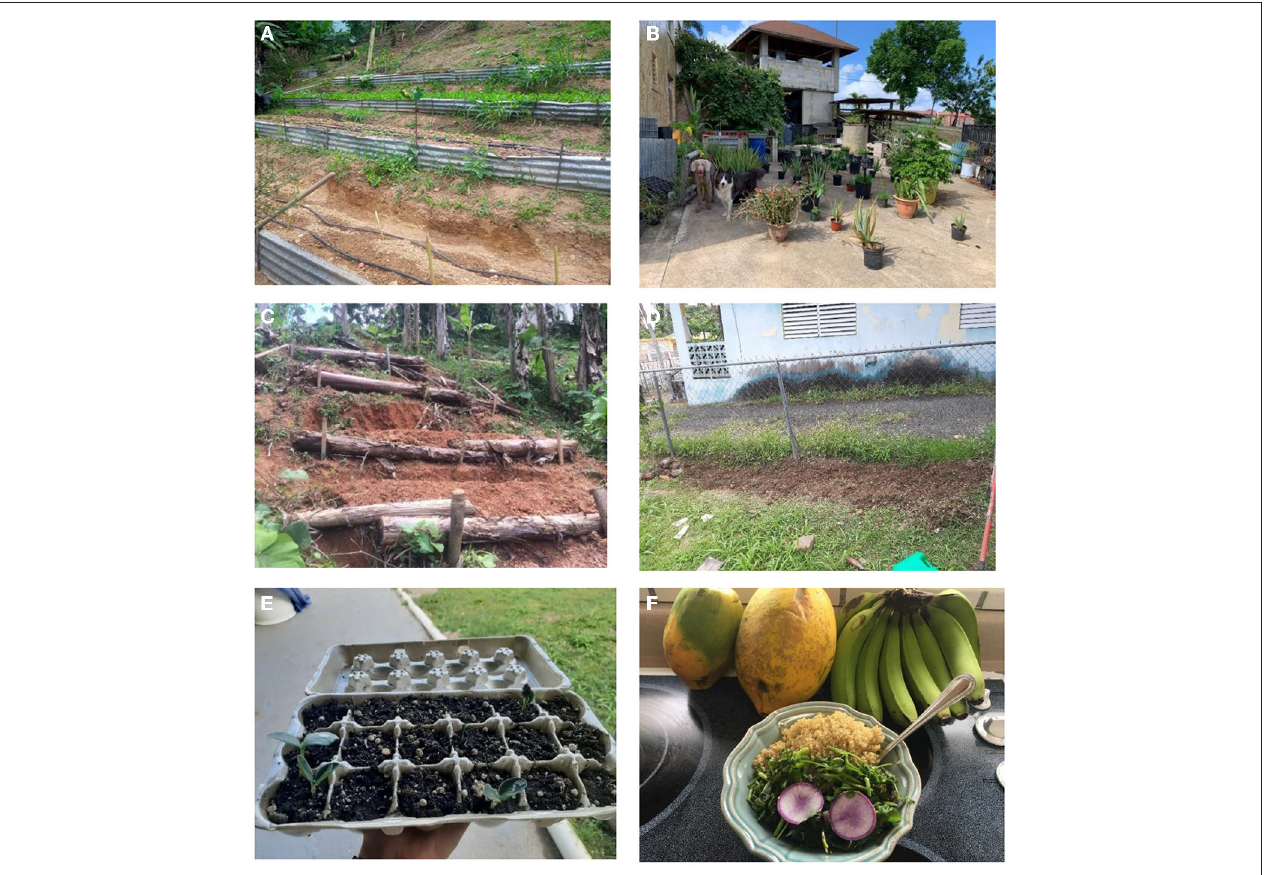
FIGURE 1 | Creation of new food production areas at home during COVID-19: photo examples from student assignments in the “agroecology in practice” module at the University of Puerto Rico at Utuado, May 2020. (A) Rural planting beds in terraces (Corozal, Puerto Rico). (B) Urban home-garden in planting pots (Toa Baja, Puerto Rico). (C) Implementation of soil erosion-mitigation practices on steep terrain (Utuado, Puerto Rico). (D) Re-designing urban areas and implementing agroecological urbanism (Caguas, Puerto Rico). (E) Recycling egg boxes as germination plates (Cidra, Puerto Rico). (F) Exploring the ethnobotany of native agricultural diversity (San Juan, Puerto Rico). [Reproduced with authors’